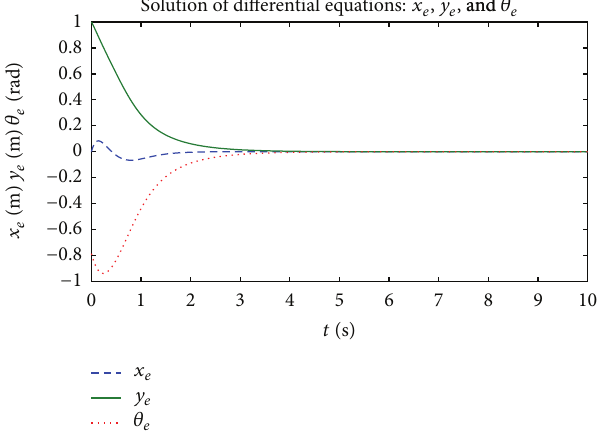
Figure 5: Diagram of error curve of straight line tracking.